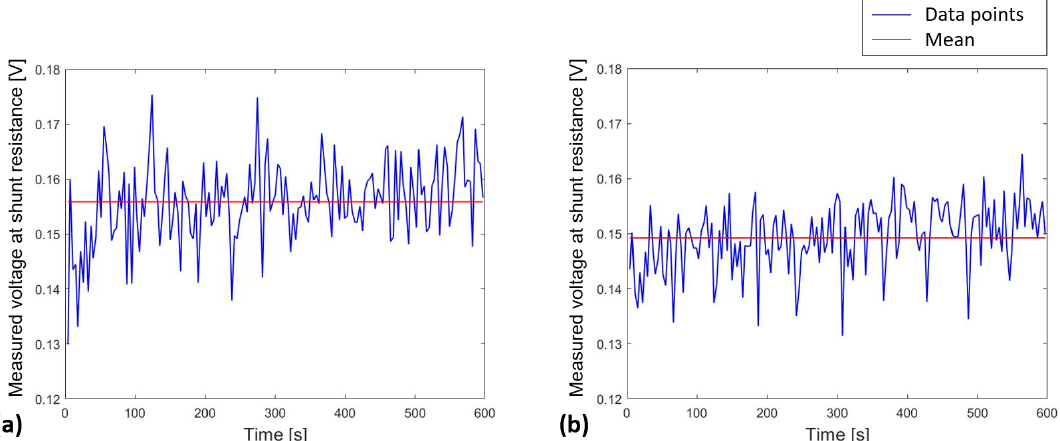
Figure 5. Operation strategy 1 at microcontroller 1 (a) and microcontroller 2 (b)